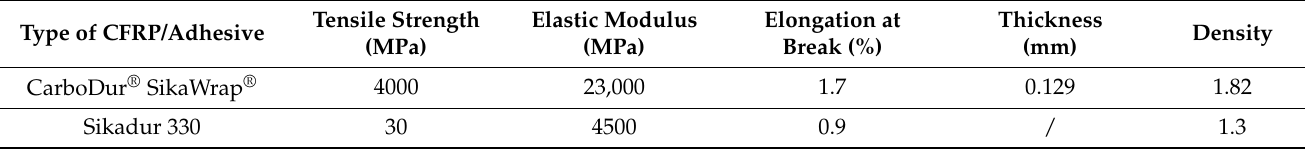
Table 4. Properties of unidirectional carbon fiber wraps and the epoxy